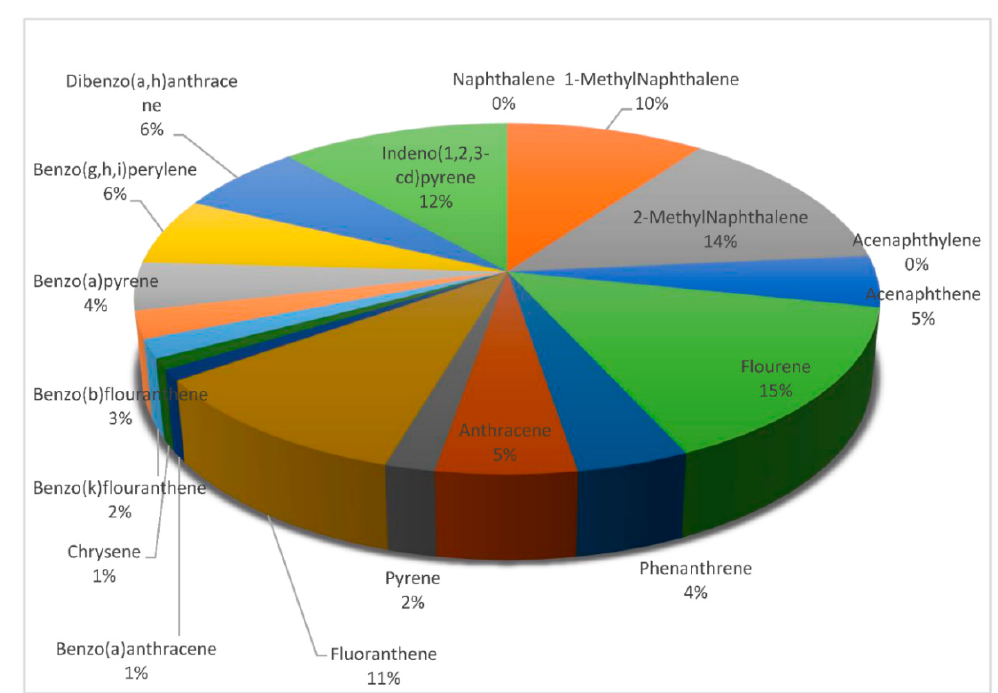
Figure 9. Percentage contributions of PAHs in the sediment samples.